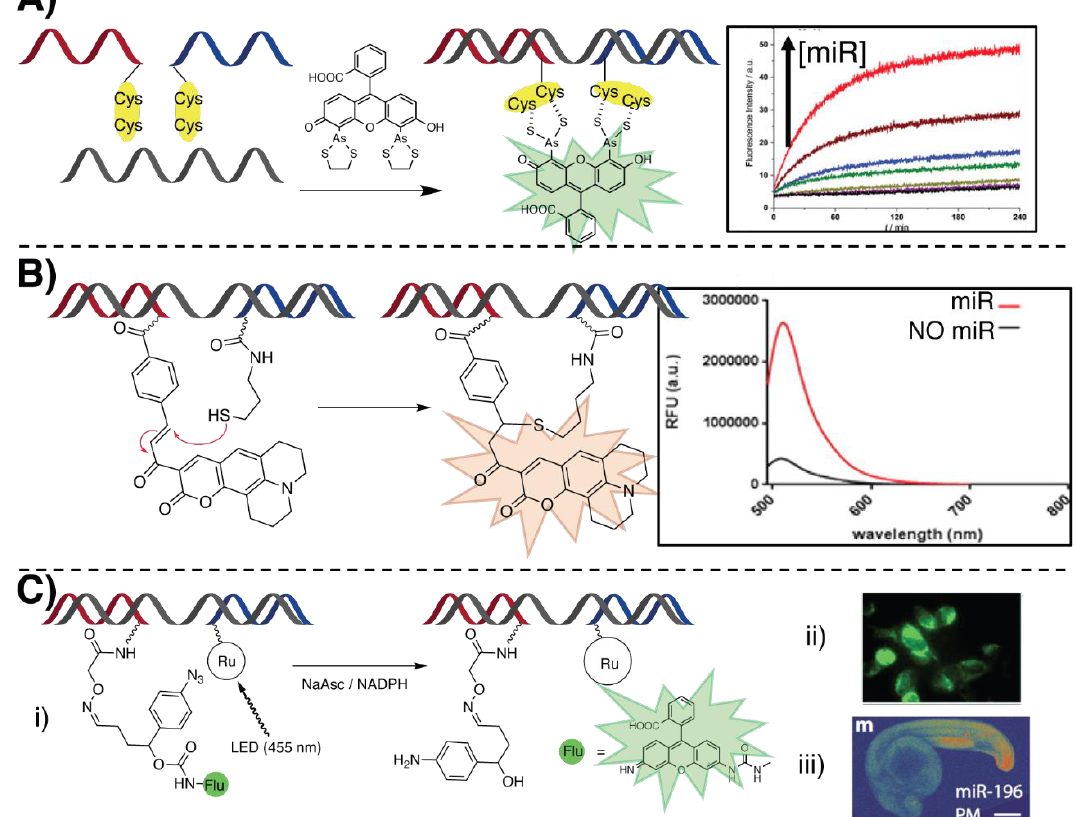
Figure 6. Illustration of some of the principal oligonucleotide templated reactions for miR detection relying on PNAs. ( A ) In situ fluorescence labelling of dicysteine PNAs for miR detection, through unmasking of FlAsh, described in [88] ( B ) Michael addition of a thiol-containing PNA to an α,β-unsaturated ketone of a nonfluorescent coumarin precursor. Adapted with permission from [90]. Copyright 2016 American Chemical Society. ( C ) Ruthenium (II)-based light-triggered reaction, freeing a quenched fluorophore upon light-mediated reduction of a pyridinium linker, as shown in [93]. (i) The reaction was conducted in cellulo ( ii, [94]) and in vivo ( iii, adapted with permission from [95]. Copy- right 2016 American Chemical Society) for miR imaging.